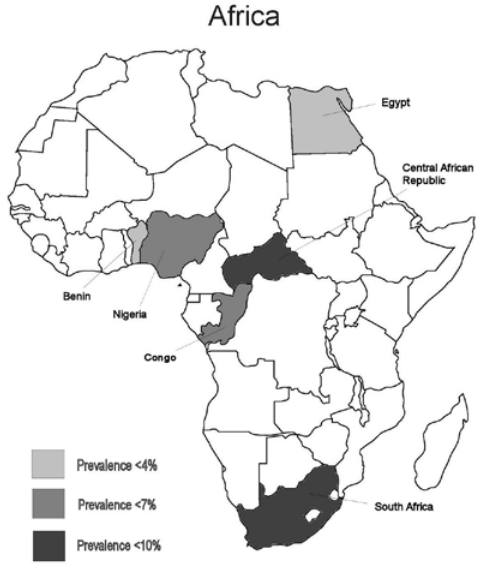
Figure 2 Geographic locations of retained studies with overall prevalence estimates; most studies were active in the period 2002–2009.